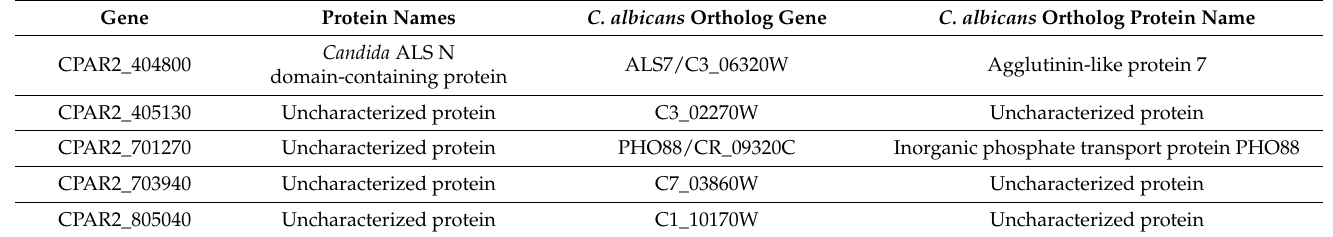
Table 3. Details of C. albicans orthologs of the C. parapsilosis antigenic proteins occurring in the membrane form or localized to extracellular